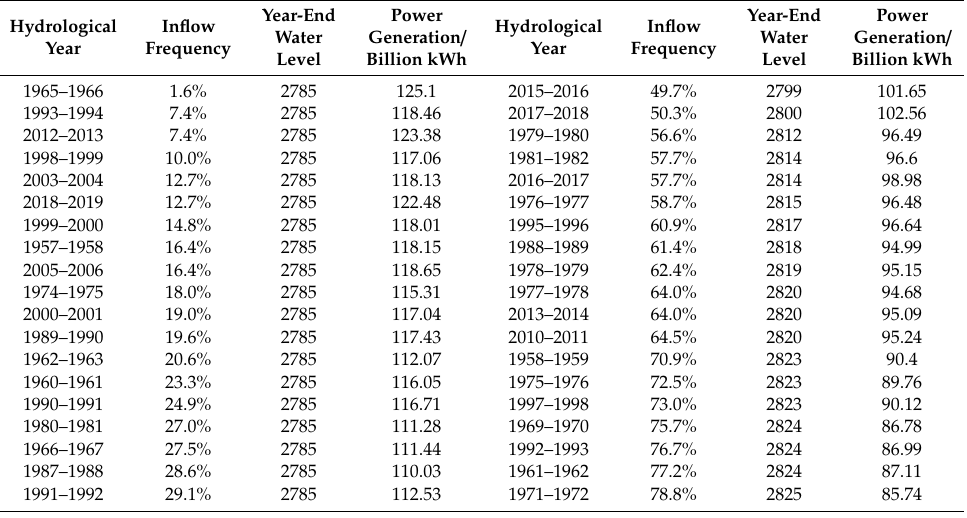
Table 10. Year-end water level of each year determined by the extracted rule and its corresponding power